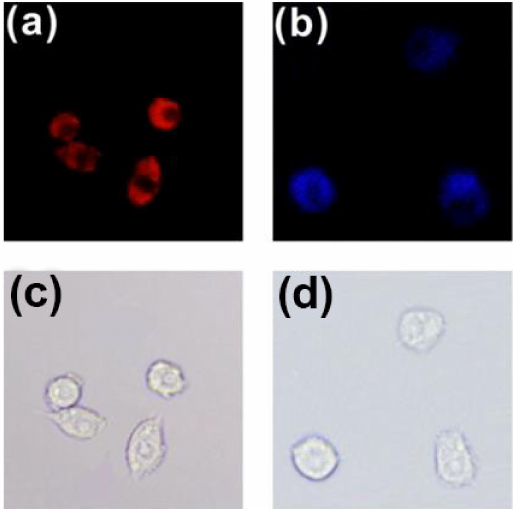
Figure 14. Fluorescence images of endogenous ClO − in RAW 264.7 cells. ( a , c ) The cells incubated with probe 5 (10 µ M) for 2 h. ( b , d ) The cells treated with PMA (2.0 mg/mL) for 30 min and then incubated with probe 5 (10 µ M) for 2 h [40].